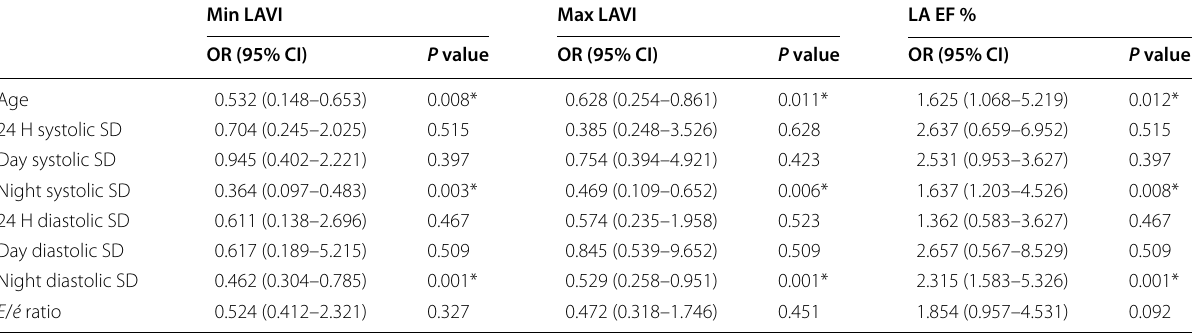
Table 6 Multivariate regression analysis for covariants affecting the LA remodeling parameters